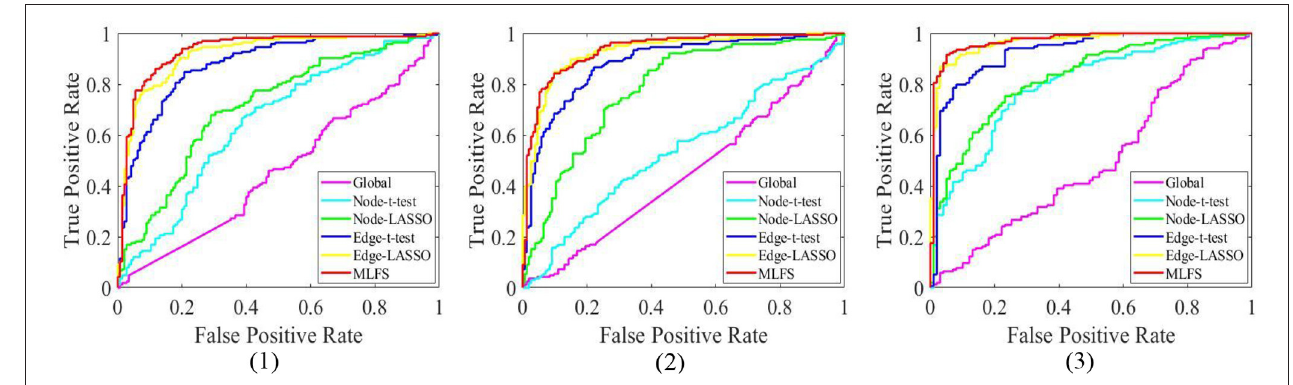
FIGURE 6 | The ROC curves achieved by all six methods in three classification tasks: (1) lMCI vs. eMCI, (2) eMCI vs. NC, and (3) AD vs. NC.